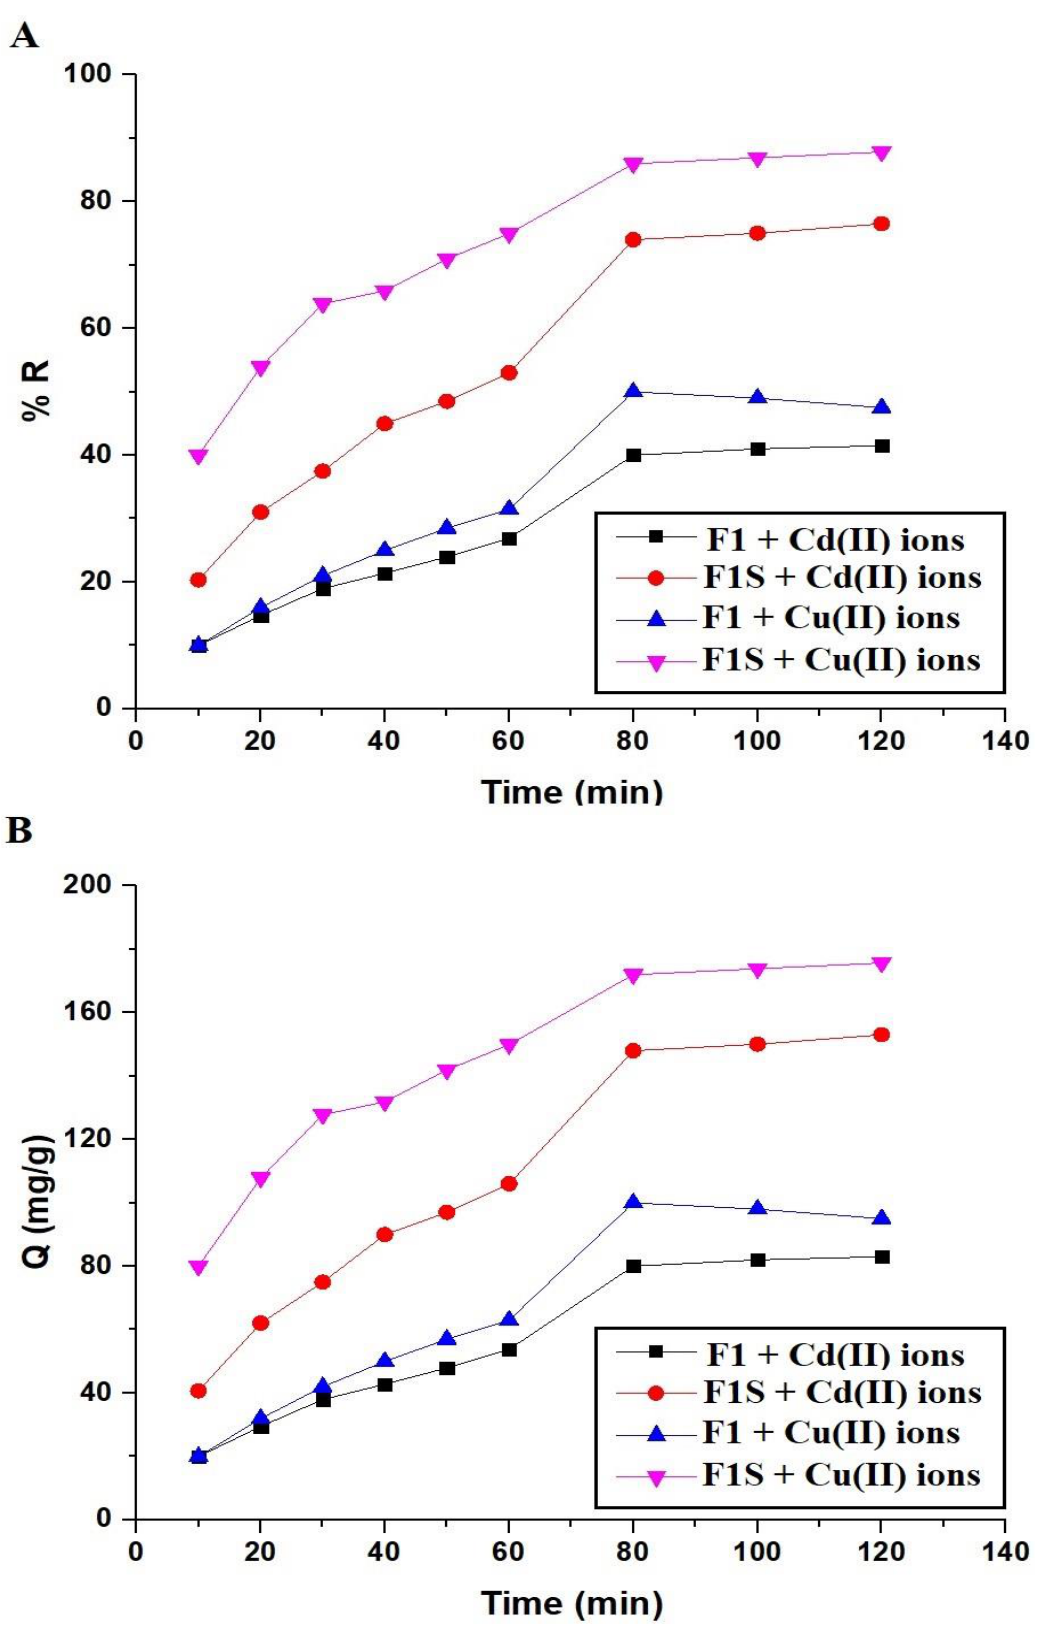
Figure 7. The effect of contact time on the % removal of copper and cadmium ions ( A ) and the adsorption capacity of the F1 and F1S samples ( B ). Experimental conditions: concentration = 200 mg/L, volume = 40 mL, amount of adsorbent = 0.04 g, and pH = 7.5.